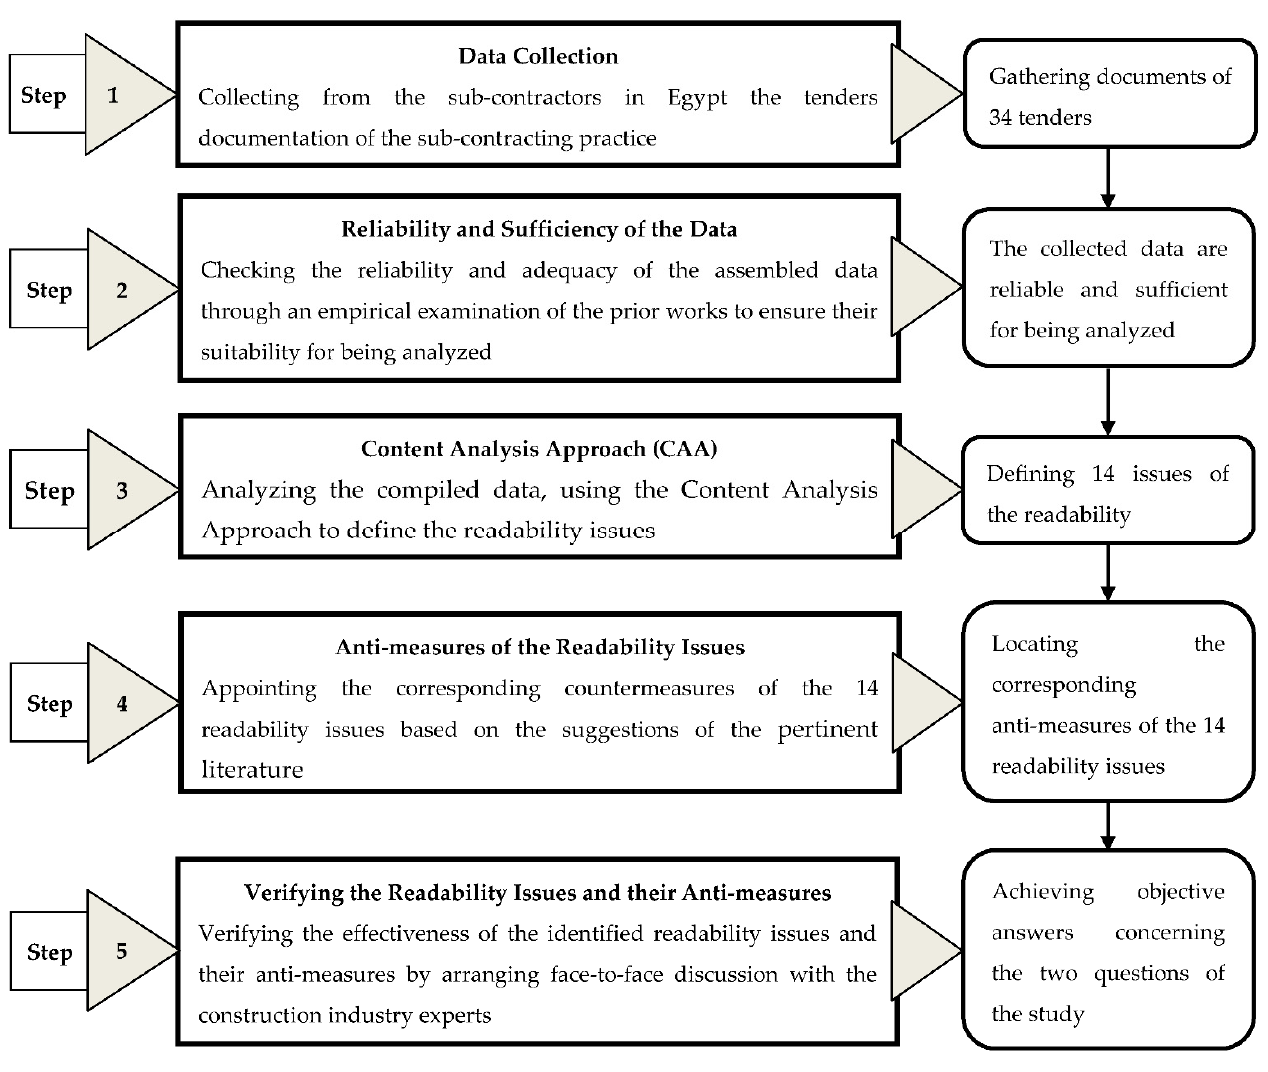
Figure 1. Research methodology